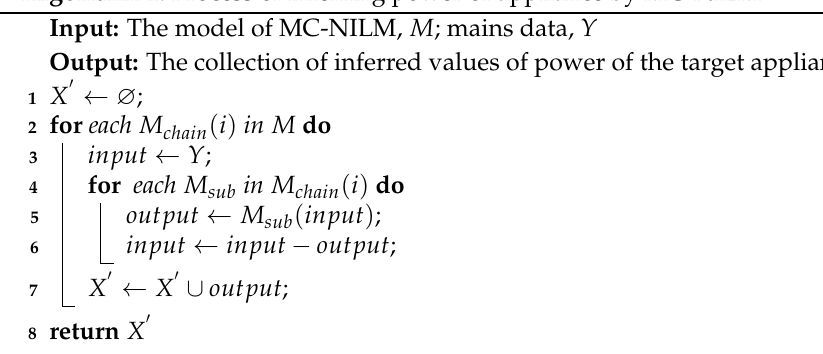
Algorithm 1: Process of inferring power of appliance by